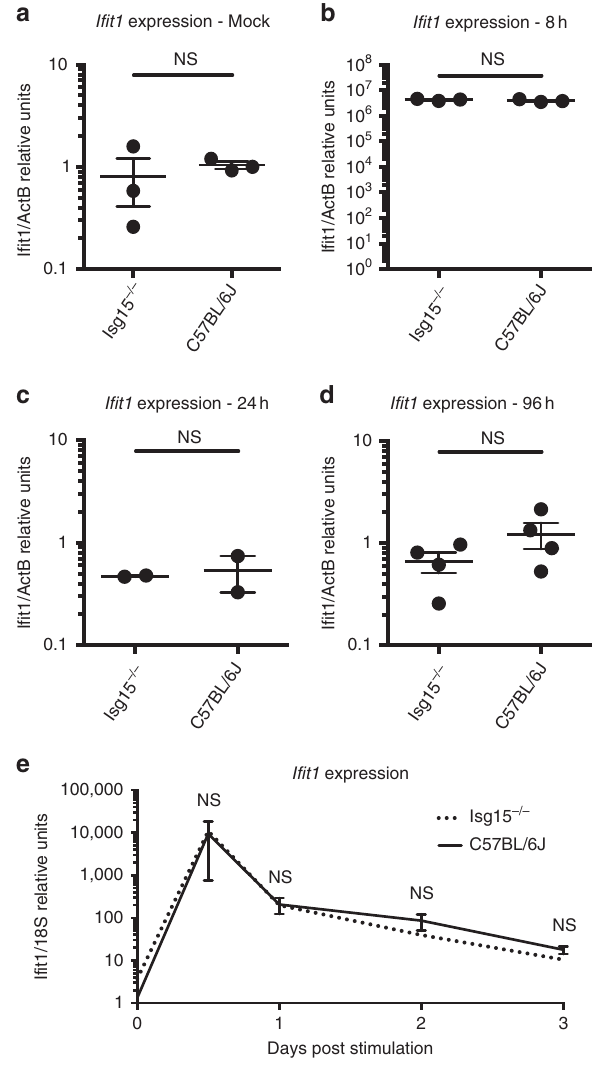
NATURE COMMUNICATIONS|7:11496|DOI: